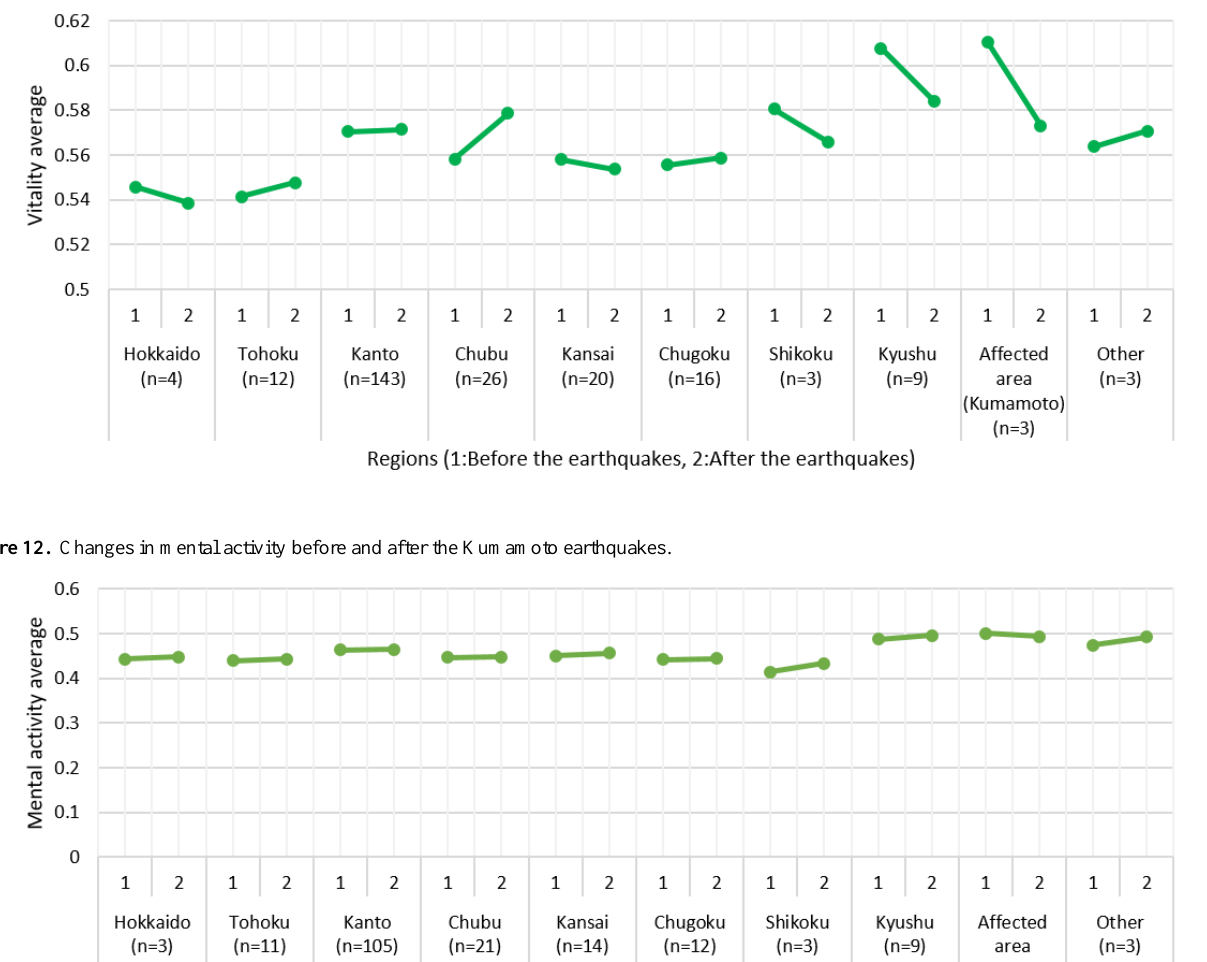
Figure 11. Changes in vitality before and after the Kumamoto earthquakes.